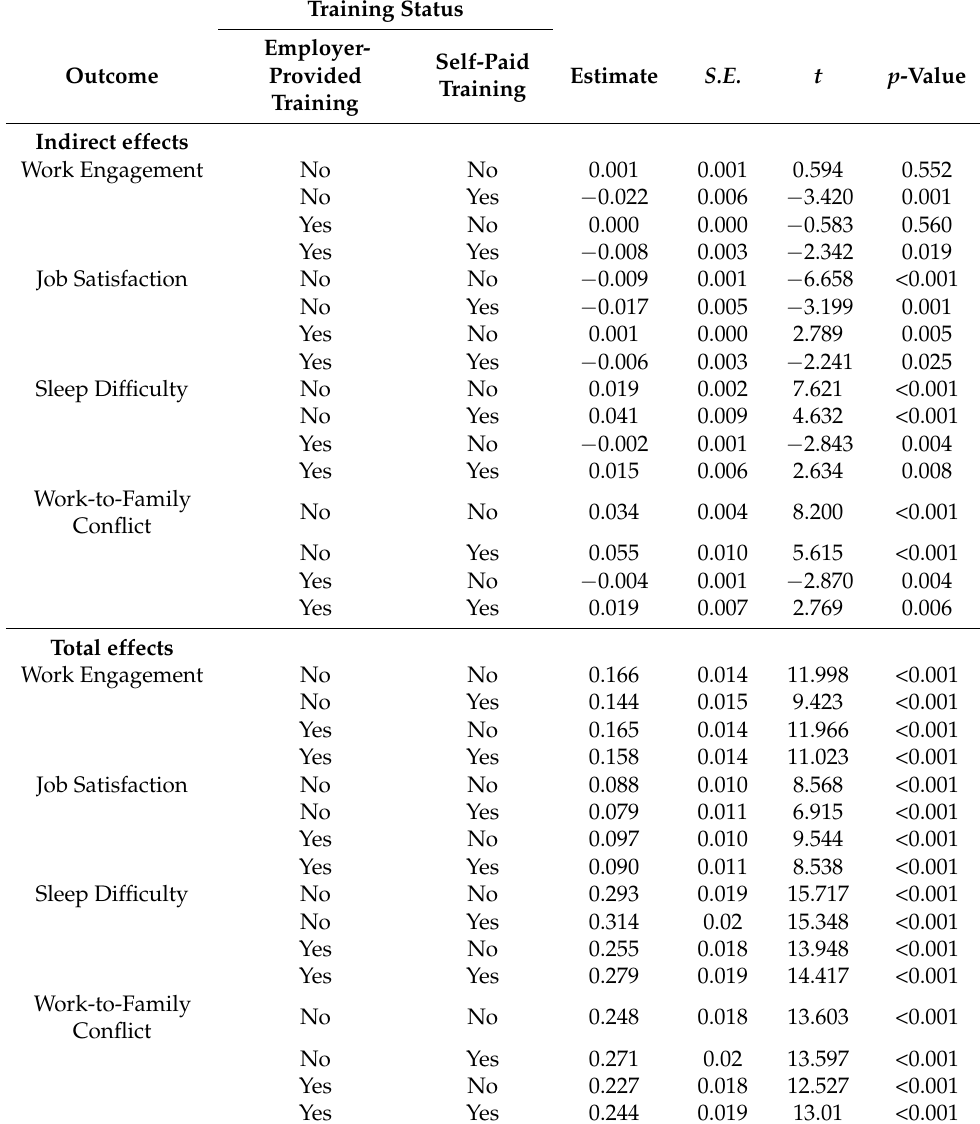
Table 4. Indirect and total effects of technology-related changes on outcomes via technology-related qualitative job insecurity by training